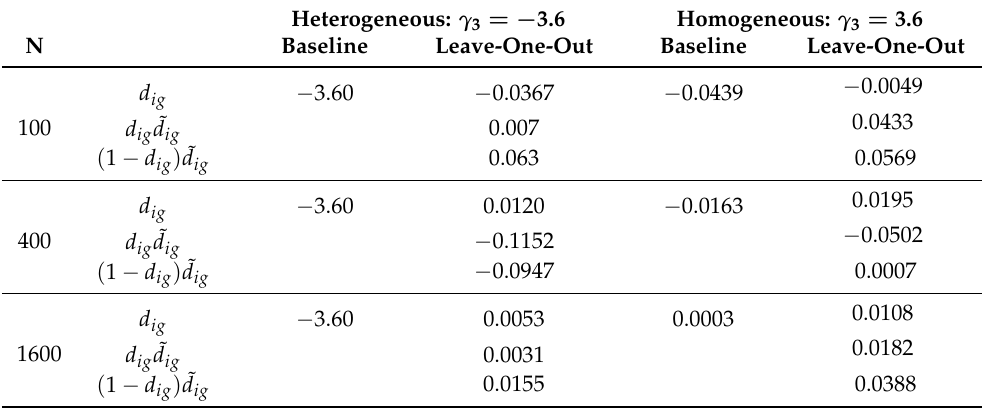
Table 1. Bias comparison of estimators. Heterogeneous: γ 3 = − 3.6 Homogeneous: γ 3 =